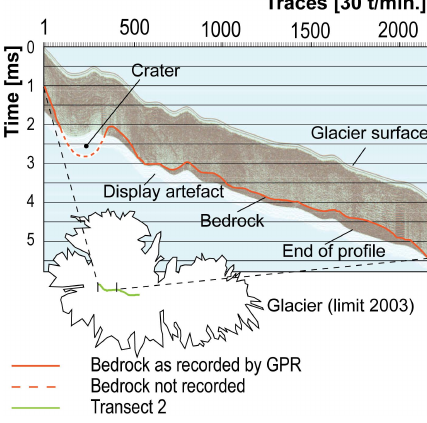
Fig. 9. Example of interpreted profile of transect 2 from the GPR on the slope to the